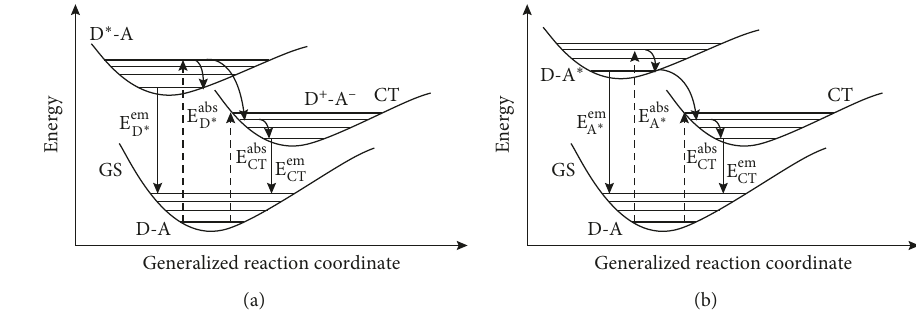
Figure 1: Photo-induced electron transfer for cases (a) and